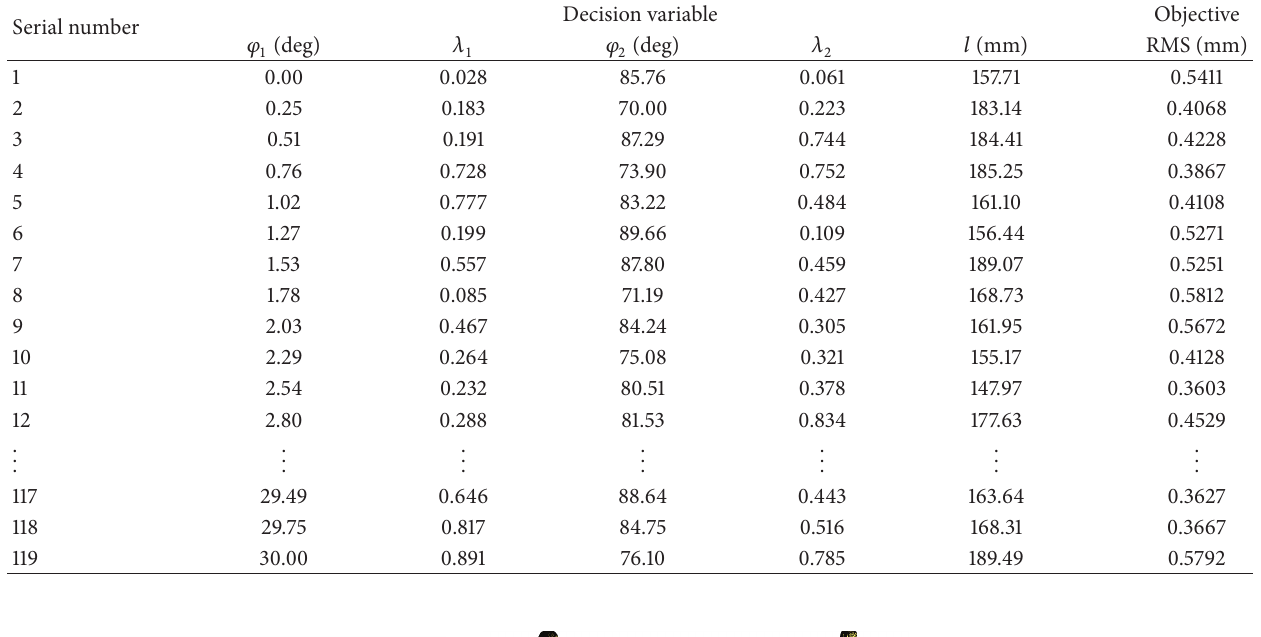
Table 2: The sample points and corresponding results of FSI simulations.